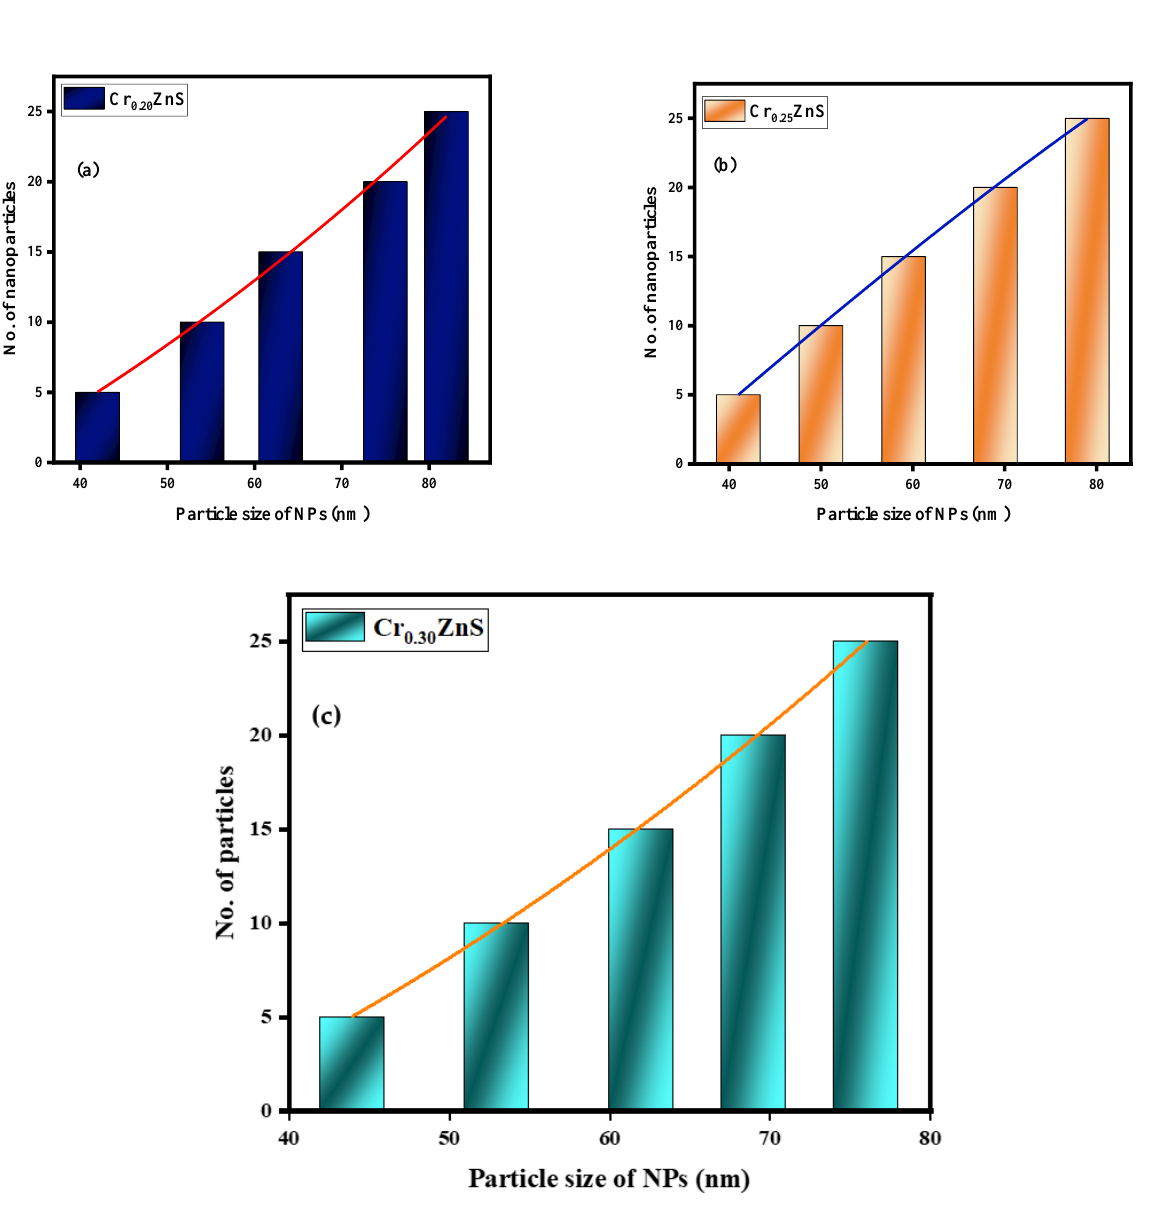
Figure 8. Particle size distribution of ( a ) Cr 0.20 ZnS, ( b ) Cr 0.25 ZnS, and ( c ) Cr 0.30 ZnS catalyst samples.